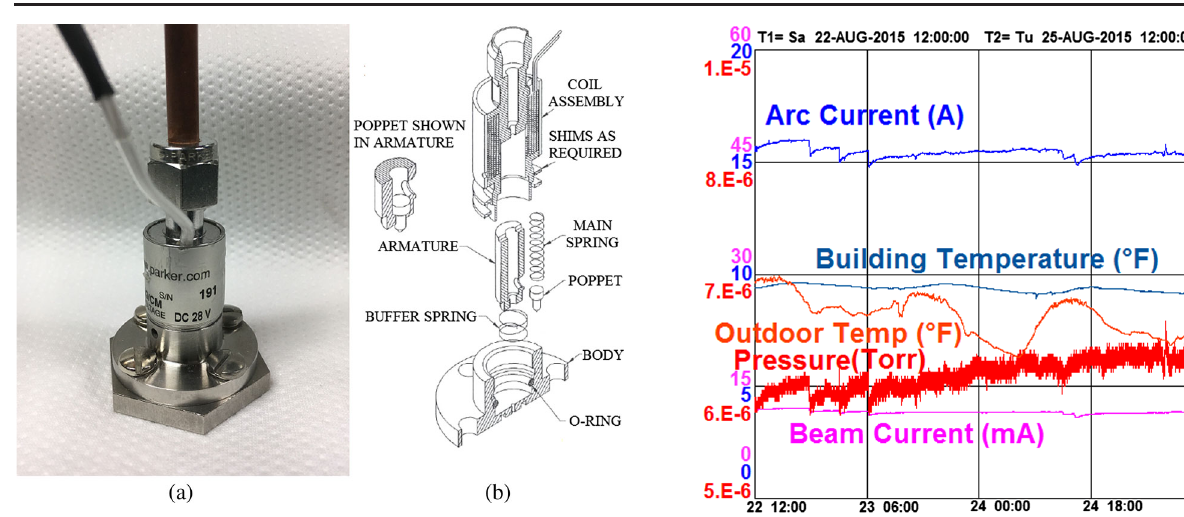
source.FIG. 5. (a) Picture of the Series 9 gas valve. (b) Schematic of the gas valve and its different